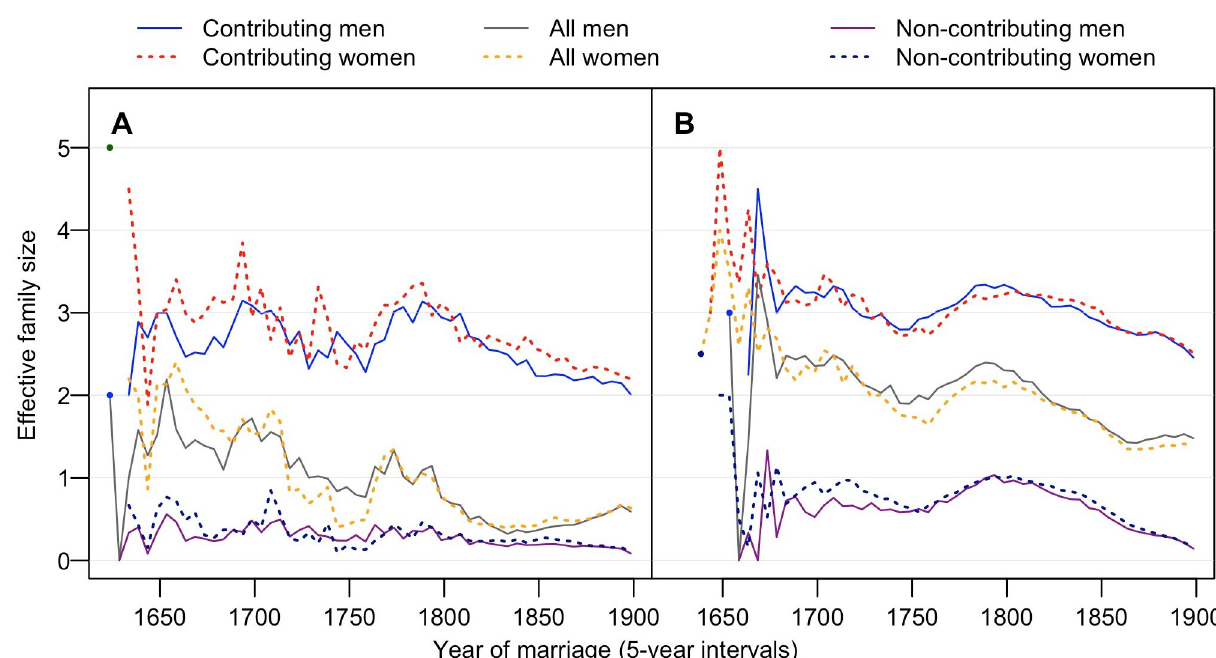
Fig 2. Effective family size of maternal and paternal lineages at different time points. Families of immigrants ( A ), and Quebec-born families ( B ), showing EFS of contributing, non-contributing descendants and their total (All). Maternal EFS-daughters are shown in dotted lines and paternal EFS- sons in solid